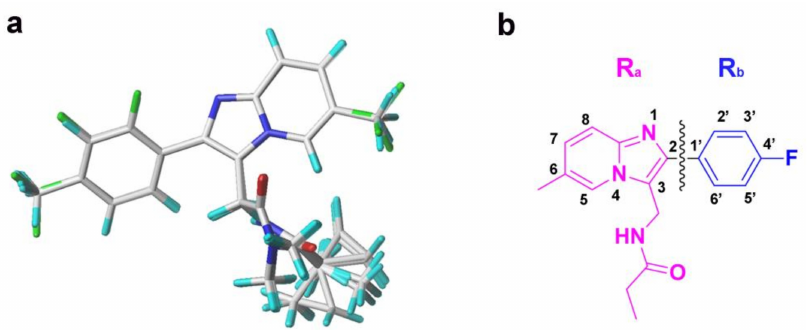
Figure 14. The molecular alignment and fragment for the 3D-QSAR models. ( a ) The alignment of all training set compounds using compound 14 as a template for the CoMFA and CoMSIA models. ( b ) The cutting style of compound 14 for the Topomer CoMFA model; R a group and R b group are colored in magenta and blue, respectively, and the cut position is represented by a wavy